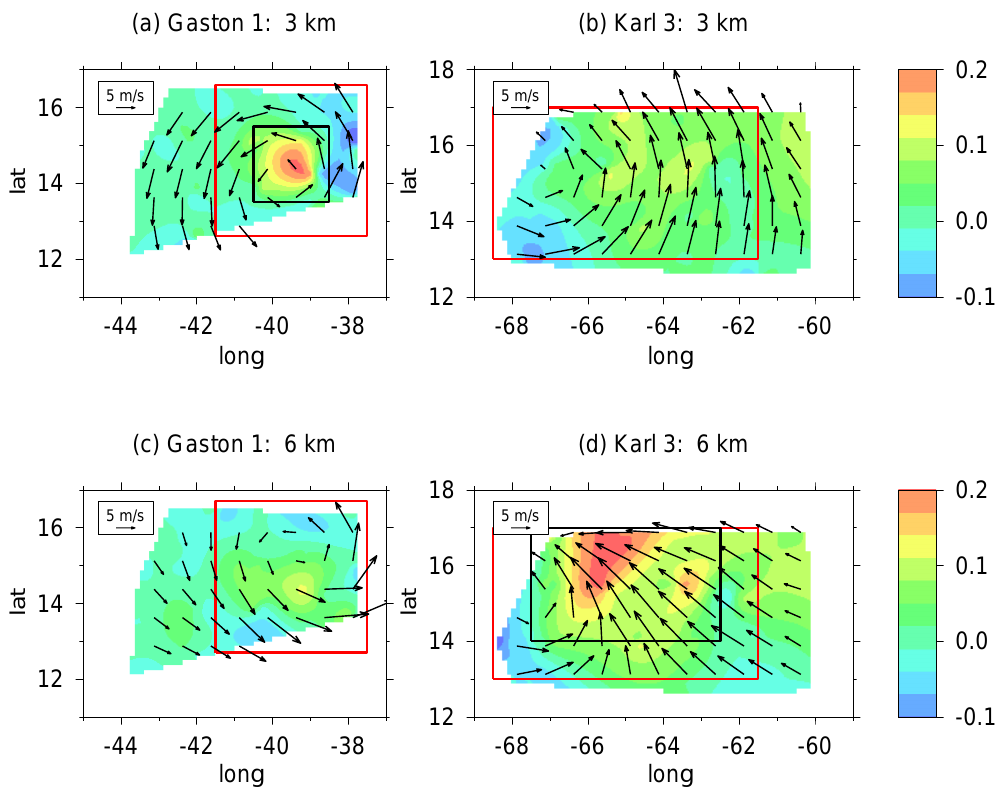
Fig. 6. Vertical mass flux and relative wind at 3km and at 6km for Gaston 1 (left panels) and Karl 3 (right panels). The units are kgm − 2 s − 1 . The red boxes enclose the area selected for analysis, and the black boxes enclose the area of convective activity.